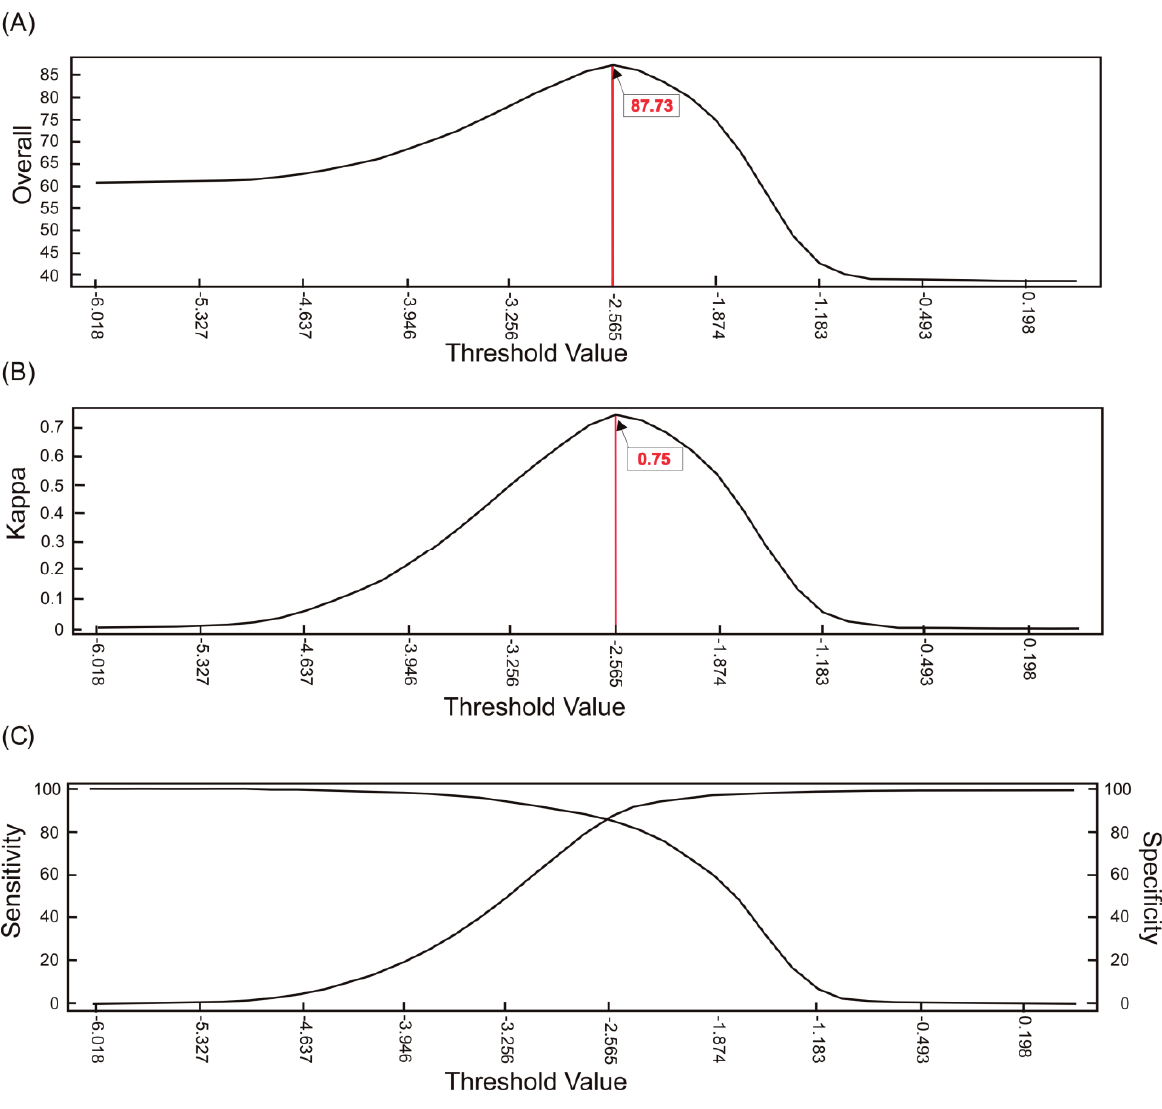
Figure 14. Identification of the optimal threshold values for burned-area detection from the standardized temporal series images. The accuracy assessment curves refer to the following indices: ( A ) Overall accuracy, ( B ) Kappa coefficient, and ( C ) Sensitivity-Specificity